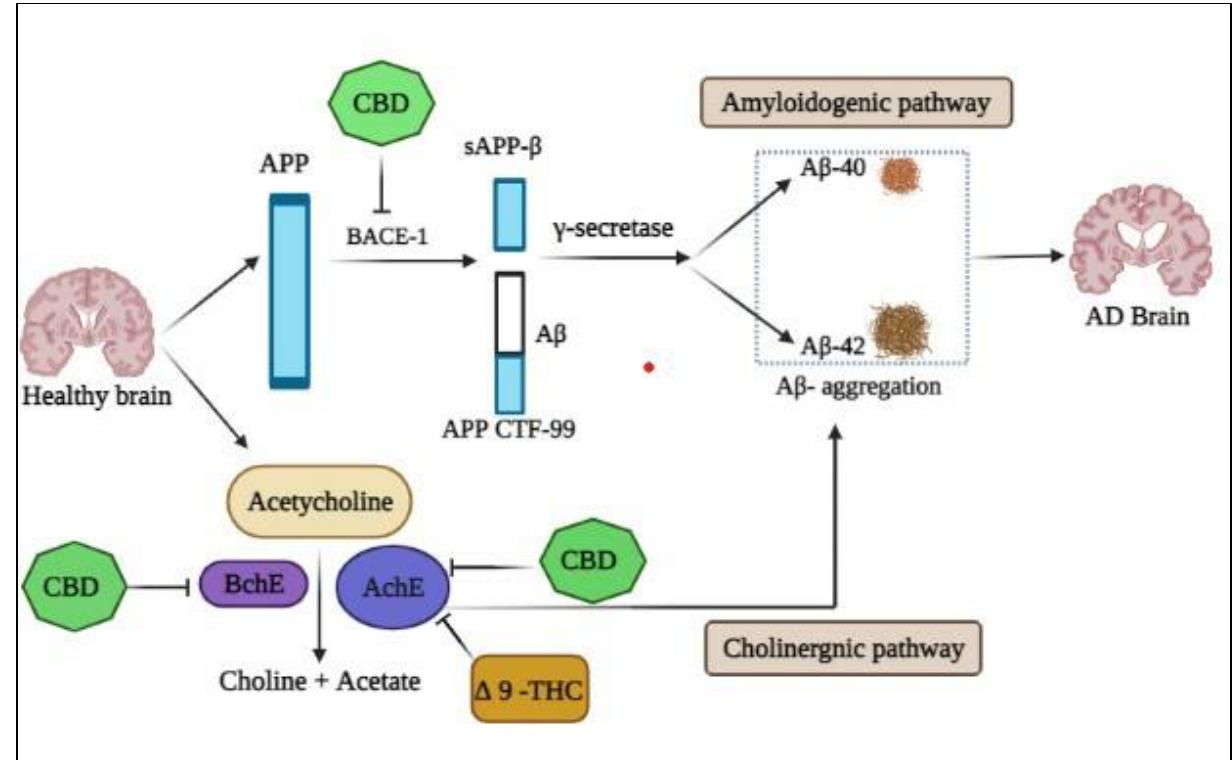
Figure 1. Inhibitory activity of Cannabis constituents on key pathways of Alzheimer’s disease. Δ -9-THC and CBD inhibits AChE and BChE. CBD also inhibits amyloid beta aggregate formation by inhibiting BACE-1.